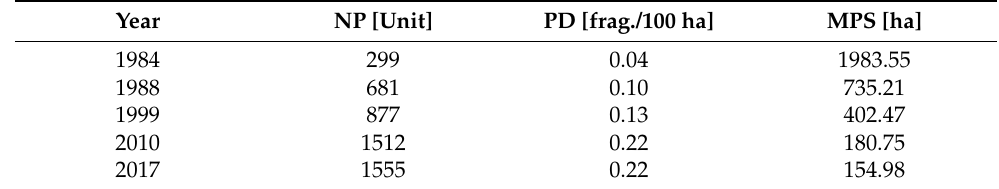
Table 3. Number (NP) density (PD) and average size of forest fragments (MPS) in the years 1984, 1988, 1999, 2010, and